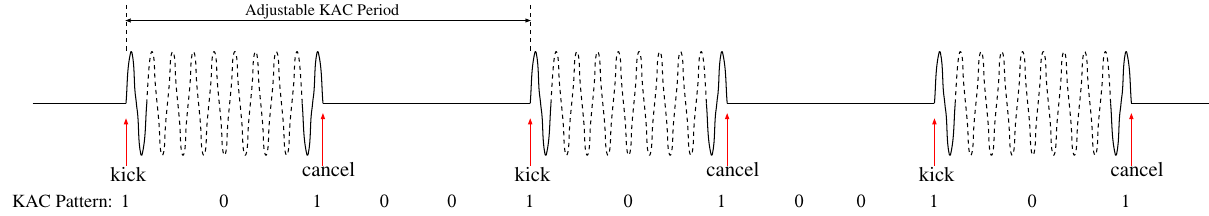
FIG. 2. Illustration of the KAC scheme in time domain. The KAC pattern is “ 10100 ” and KAC period is 5 orbital turns.